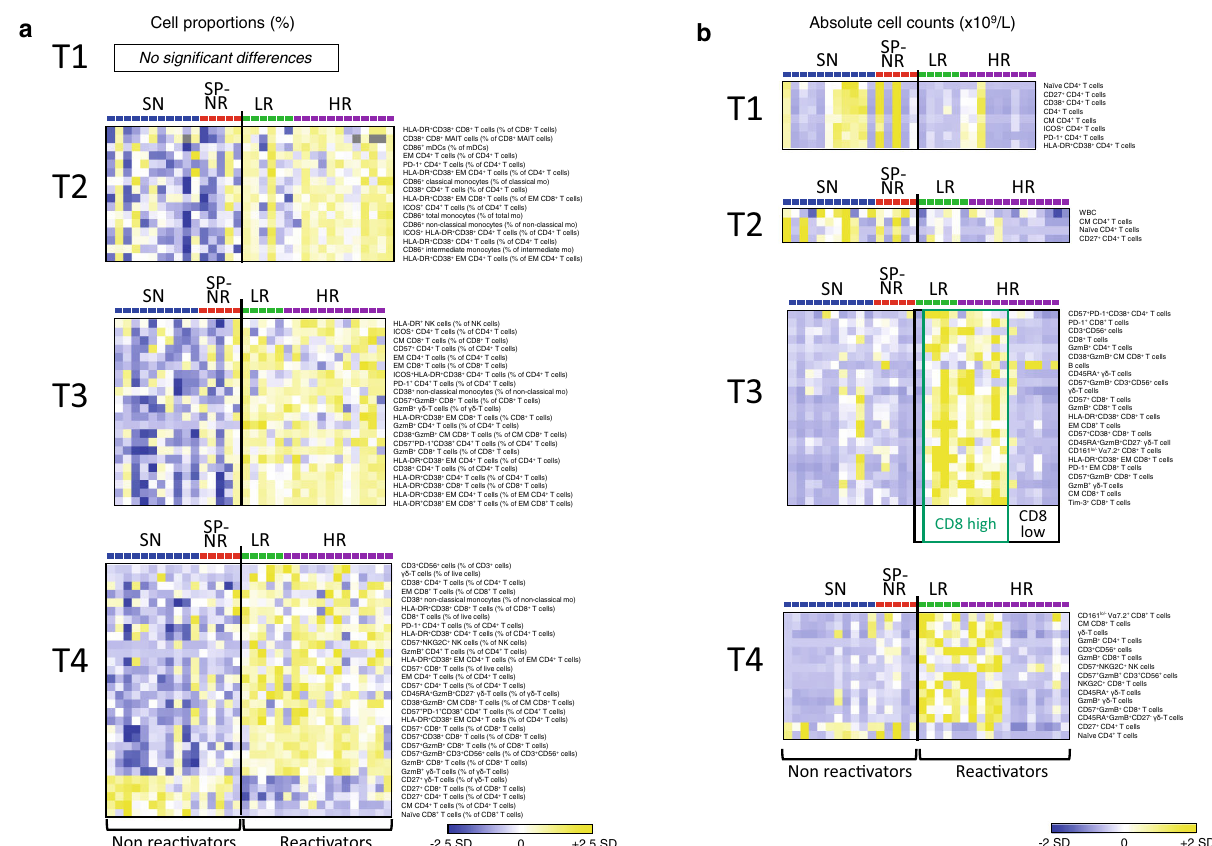
Fig. 3 Distinct immune reconstitution pattern in HSCT recipients with HCMV reactivation. a Heat map rows display percentages of immune cell subsets that were signi fi cantly different between HSCT recipients who did (LR, HR) or did not (SN, SP-NR) experience HCMV reactivation in the fi rst 100 days post-transplant. Percentages are expressed as percent of live cells and/or percent of parent subset. Signi fi cance was determined using two-class unpaired signi fi cance analysis of microarrays (SAM) involving 88 cell subsets per time-point (see Supplementary Table 4). Heat maps are coloured by the Z-score normalised per row (cell subset). Grey colour indicates missing data (too few cells in parent gate to accurately gate subpopulation). Each column represents a patient. b Heat map rows display cell subsets (absolute cell counts; x10 9 /L blood) that differ signi fi cantly between HCMV reactivators (LR, HR) and non-reactivators (SN, SP-NR) as determined by two-class unpaired SAM analysis involving 77 populations per time-point (see Supplementary Table 5). For T3 in ( b ), a FDR of 3.614% was used (0.831/23 subsets shown are false discoveries). Heat maps are coloured by the Z-score normalised per row (cell subset). Each column represents a patient. Patients with HCMV reactivation were subsequently strati fi ed into ‘ CD8 high ’ (dark green box) or ‘ CD8 low ’ (black box) groups according to the presence or absence of the elevated CD8 + T cell dominated pro fi le observed at T3. See Supplementary Fig. 3 for a schematic representation of cell subsets shown in Fig. 3a, b. T1 is prior to the detection of HCMV reactivation; T2, at the initial detection of HCMV reactivation; T3, the peak; T4, near the resolution of HCMV reactivation. Naive (CD45RA + CD45RO - CCR7 + CD27 + ), CM (central memory; CD45RA - CD45RO + CCR7 + CD27 + ), EM (effector memory; CD45RA - CD45RO + CCR7 - CD27 - ), Mo (monocyte). T1 (SN n = 11, SP-NR n = 5, LR n = 5, HR n = 9), T2 (SN n = 11, SP-NR n = 5, LR n = 6, HR n = 12), T3 (SN n = 10, SP-NR n = 5, LR n = 5, HR n = 12), T4 (SN n = 11, SP-NR n = 5, LR n = 5, HR n = 13). SN HCMV-seronegative (blue), SP-NR Seropositive no reactivation (red), LR Low-level HCMV reactivation (green), HR High-level HCMV reactivation (purple), SD Standard deviation. Source data are provided as a Source Data fi